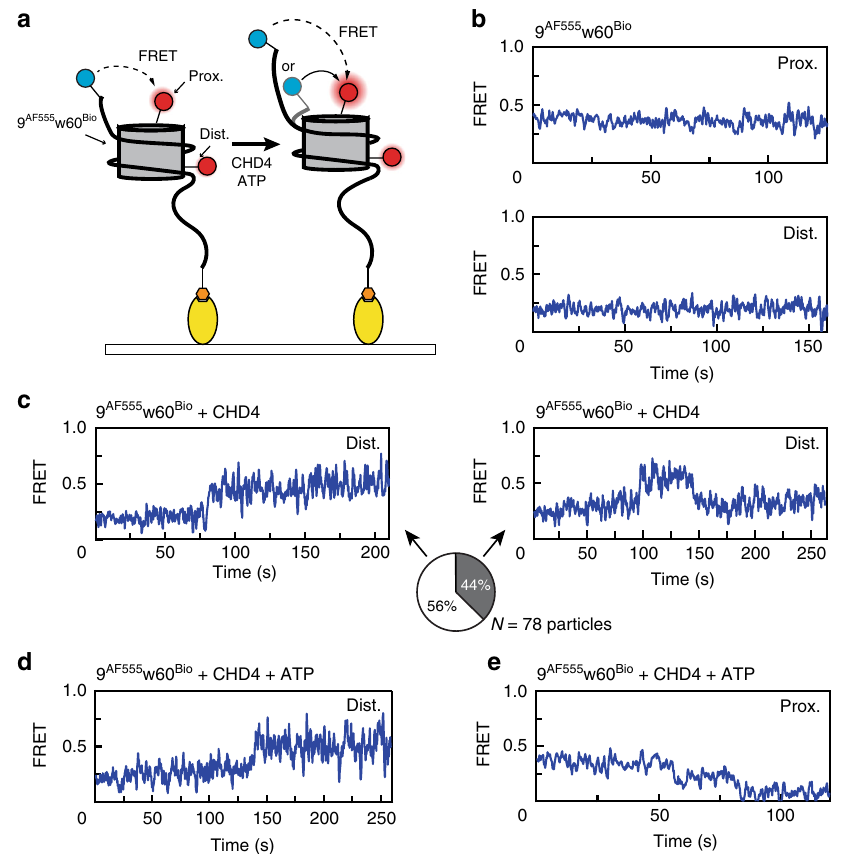
Fig. 6 CHD4 induces similar FRET changes in extra-nucleosomal DNA at the TA-rich side. a Schematic showing the labelling scheme for 9 AF555 w60 Bio and the two possible remodelling directions after treating with CHD4, depending on whether the ‘ 9 ’ end acts as an entry or an exit side. b FRET vs time traces for 9 AF555 w60 Bio alone with a proximal (top) or distal (bottom) H2A AF647 label. c FRET vs time trace for 9 AF555 w60 Bio bearing a distal AF647 label, showing an increase upon the addition of 2 nM CHD4. This newly established structure can be relatively stable (left) or can be transient, dropping back to the initial state (right). The proportions of each scenario (from 78 particles) are illustrated as a pie chart. d FRET vs time trace for distally labelled 9 AF555 w60 Bio in presence of both 2 nM CHD4 and 1 mM ATP, showing an increase to a similar level to that of CHD4 alone. e FRET vs time trace for proximally labelled 9 AF555 w60 Bio , showing a stepwise drop upon treatment with 2 nM CHD4 and 1 mM ATP. In this case, the AF555 tag at the ‘ 9 ’ end is moving away from the histone octamer, in contrast to the direction of movement observed in ( d